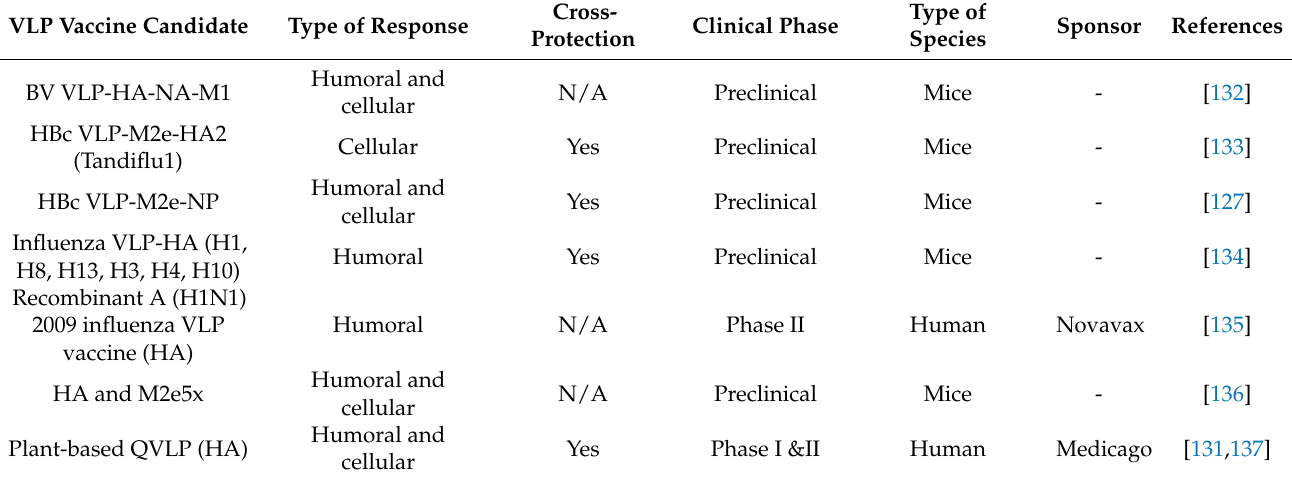
Table 2. Current VLP influenza vaccine candidates in preclinical and clinical